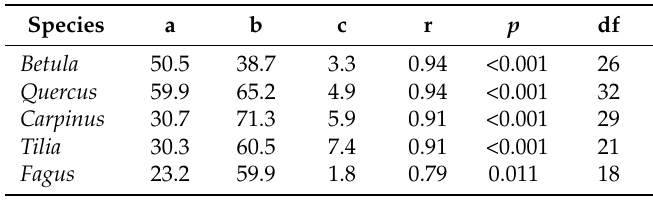
Table 4. Parameters a, b, and c of exponential regression equations of the form y = a + b x c for the dependence of leaf mass area (LMA) on relative height in the crown for the five species. Correlation Forests 2019 , 10 , 265 7 of 16 coefficients r, p -values, and degrees of freedom are also given. Each data point refers to the mean of five sets of measurements on branches where each of the 25 leaves were investigated. Species